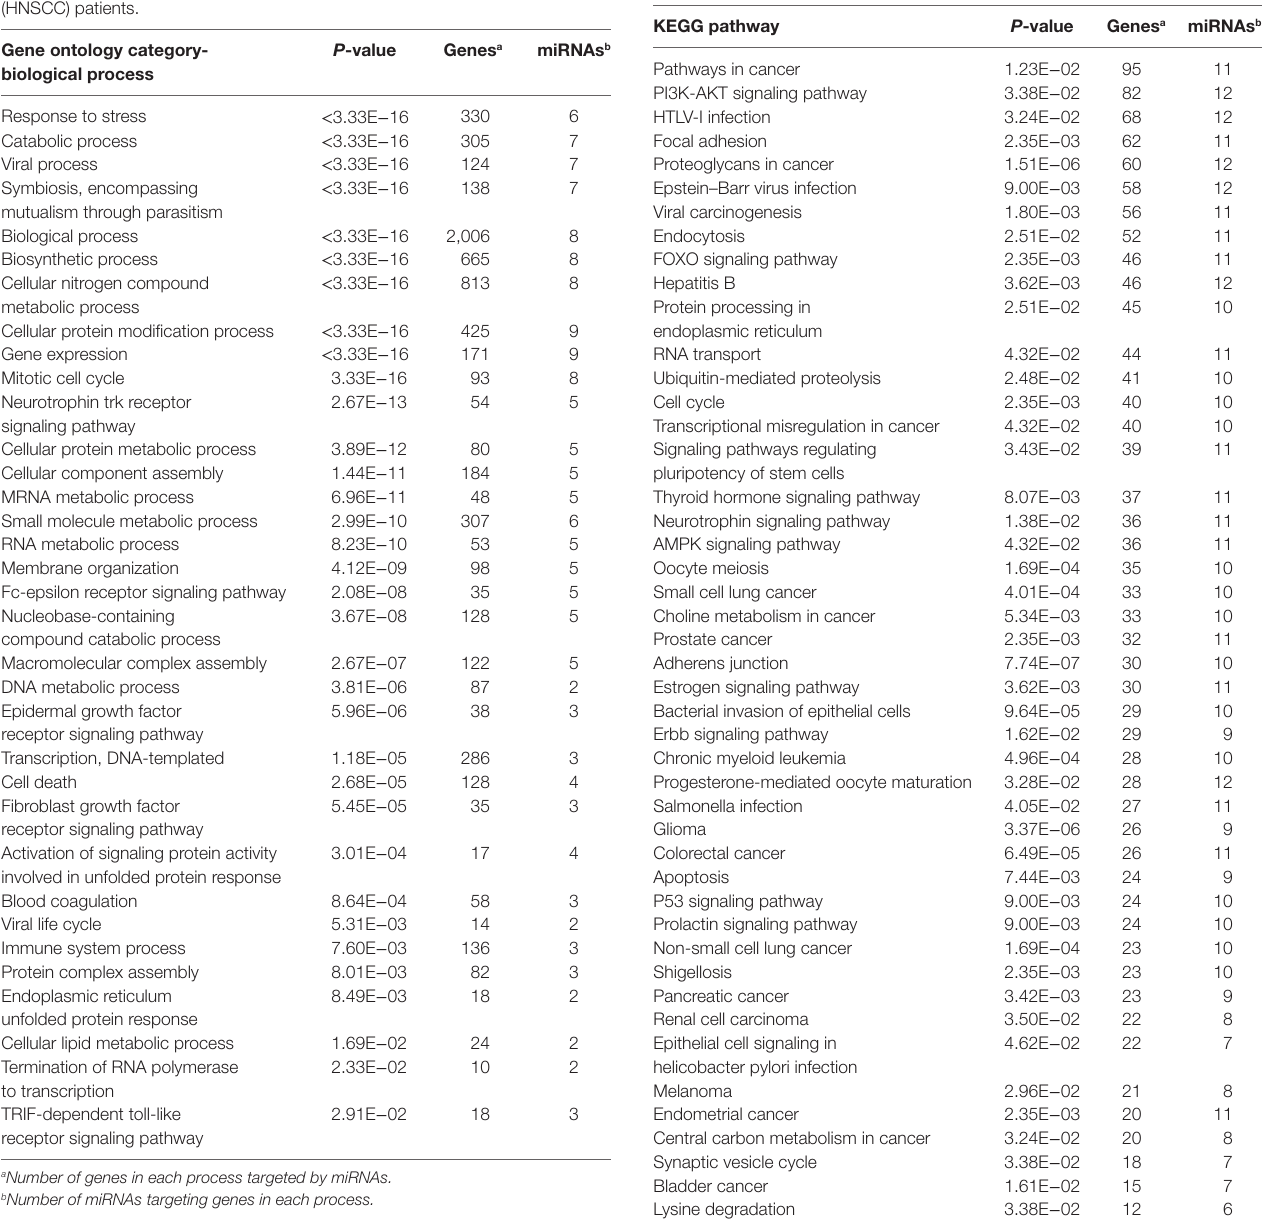
TaBle 5 | KEGG pathways of target genes of 16 microRNAs (miRNAs) differentially expressed in cells treated with serum from healthy individuals compared with head and neck squamous cell carcinomas